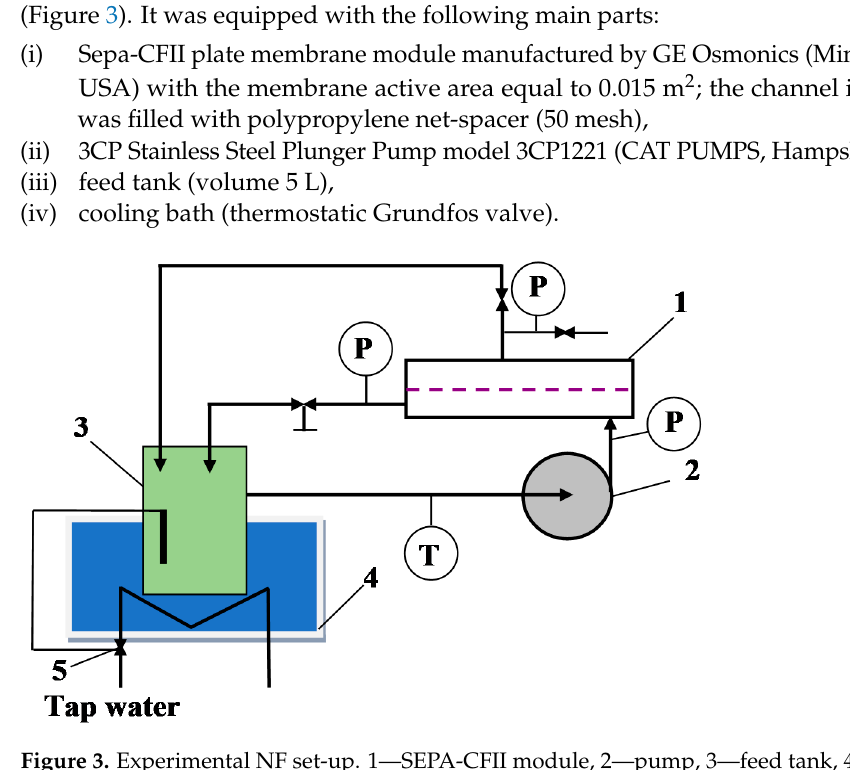
Figure 4. Structure of NF270 membrane. PA-polyamide, PS-polysulfone, PET-polyester.